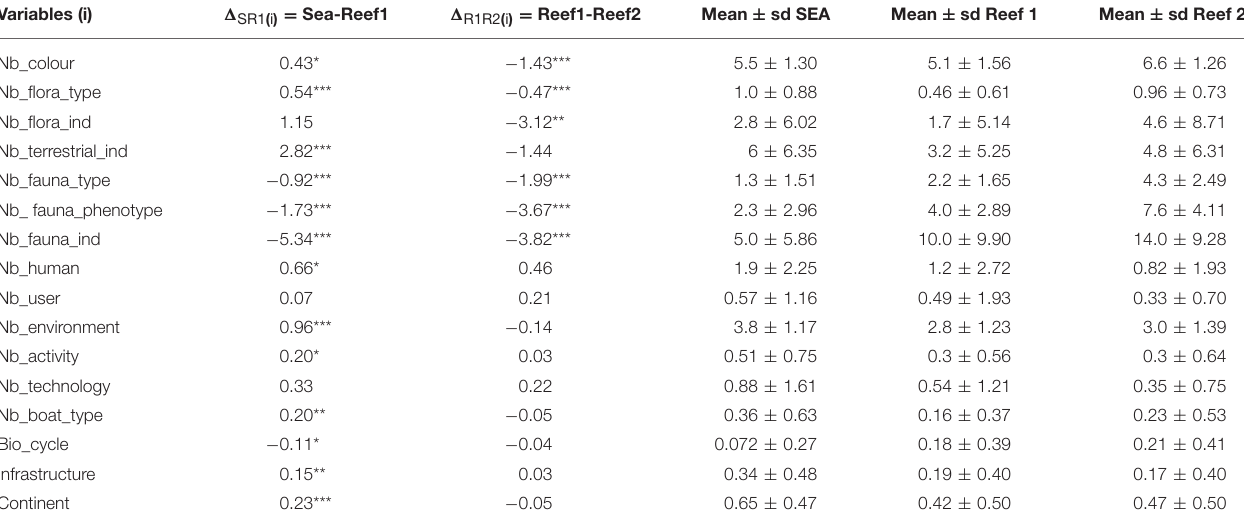
TABLE 4 | Deviation for each variable between Sea/Reef1 and Reef1/Reef2: Mean of deviation and t -test of paired data with significance (*** p < 0.001, ** p < 0.01, * p < 0.05). Variables (i)